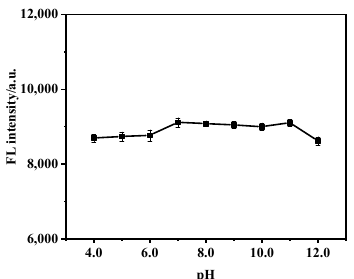
Figure 7. Effect of pH on the fluorescence of MIP@SiO 2 @QDs (taking the pH of 8.0 as the suitable condition for subsequent research).